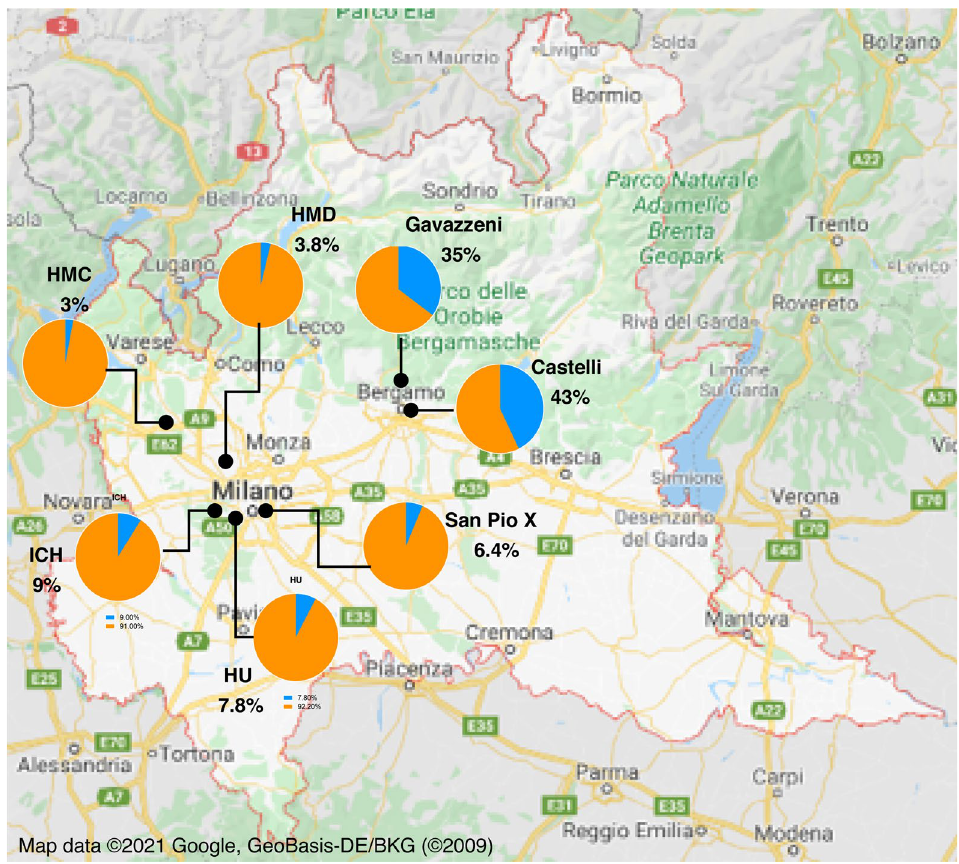
Figure 1. Distribution of IgG positivity (≥ 12 AU/mL) across different geographical areas and healthcare facilities in Lombardy, Italy. Employees from 7 different healthcare facilities were analyzed for their anti-SARS- CoV-2 IgG positivity. Pie charts show the percentage of negative subjects (IgG < 12 AU/mL) (orange) and that of positive subjects (IgG ≥ 12 AU/mL) (blue) in each site: Istituto Clinico Humanitas (ICH), Rozzano (MI); Humanitas Gavazzeni, Bergamo; Humanitas Castelli, Bergamo; Humanitas Mater Domini (HMD), Castellanza (VA); Humanitas Medical Center (HMC), Varese (VA); Humanitas University (HU), Pieve Emanuele (MI); Humanitas San Pio X, Milan, (MI). Satellite imagery has been modified from Google Maps (Map data 2021 Google, GeoBasis-DE/BKG (2009) Legal Notices https:// www. google. com/ intl/ it_ US/ help/ legal notic es_ maps/).